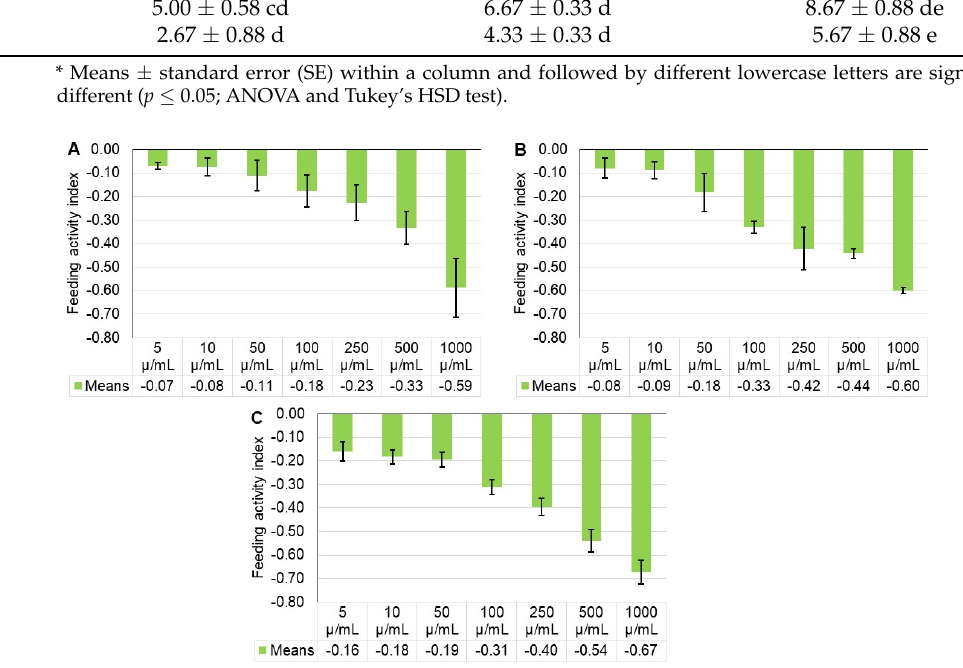
Figure 2. Feeding activity index (mean ± standard error) for Oligonychus punicae in response to different concentrations of Magnolia tamaulipana ethanolic powdered extract at ( A ) 24 h, ( B ) 48 h, and ( C ) 72 h.